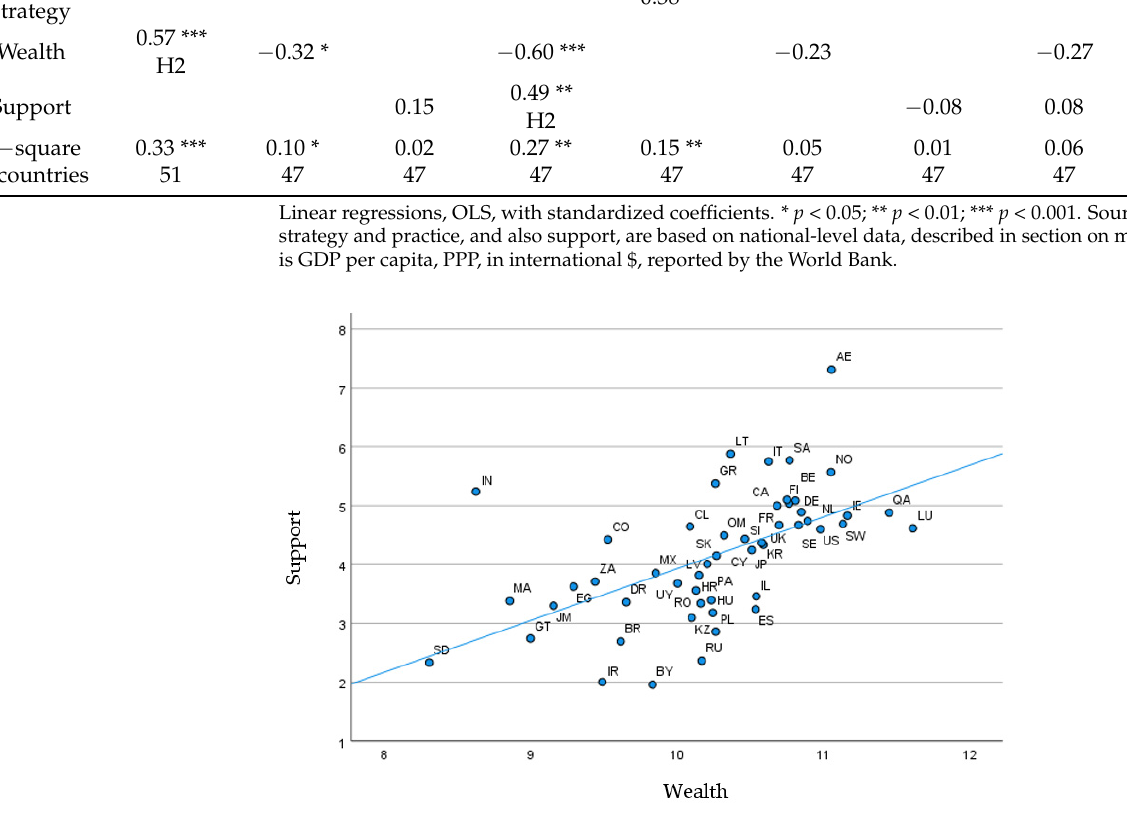
Figure 3. Countries plotted according to their wealth and their support. Sources: Support is based on national-level data, described in section on research method. Wealth is GDP per capita, originating from the World Bank.